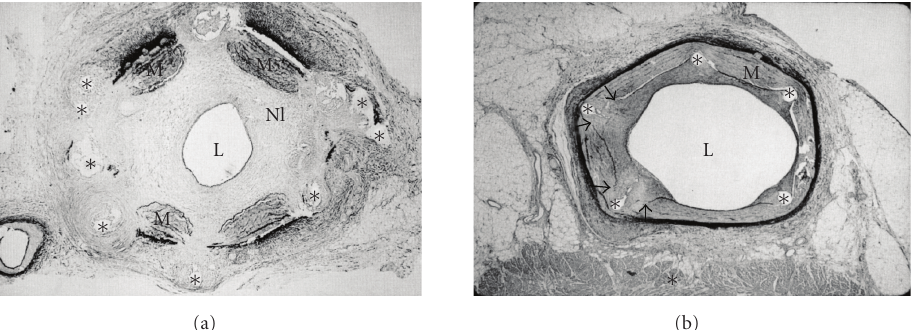
Figure 4: (a) Photomicrographic section shows gross neointimal proliferation causing a significant stenosis (Hematoxylin-Eosin stain, x5). (b) In this section, the porcine coronary was totally occluded with neointimal hyperplasia. L: lumen; M: media; NI: neointima; ∗ : stent strut. Adapted from the reference [32].